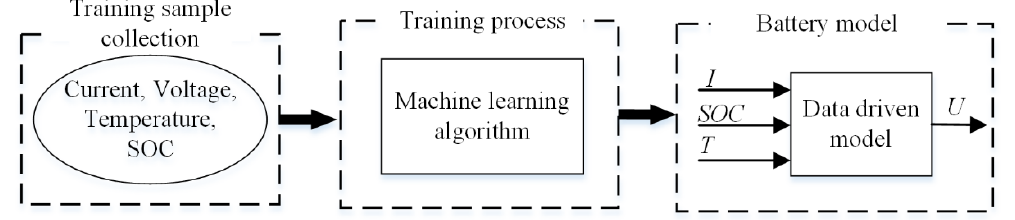
Figure 3. The process of establishing the data-driven model.